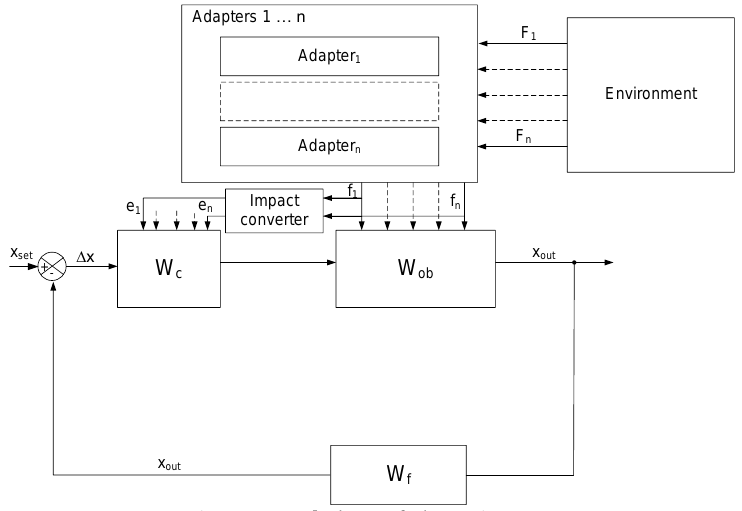
Fig. 6 Structural scheme of adaptronic system.